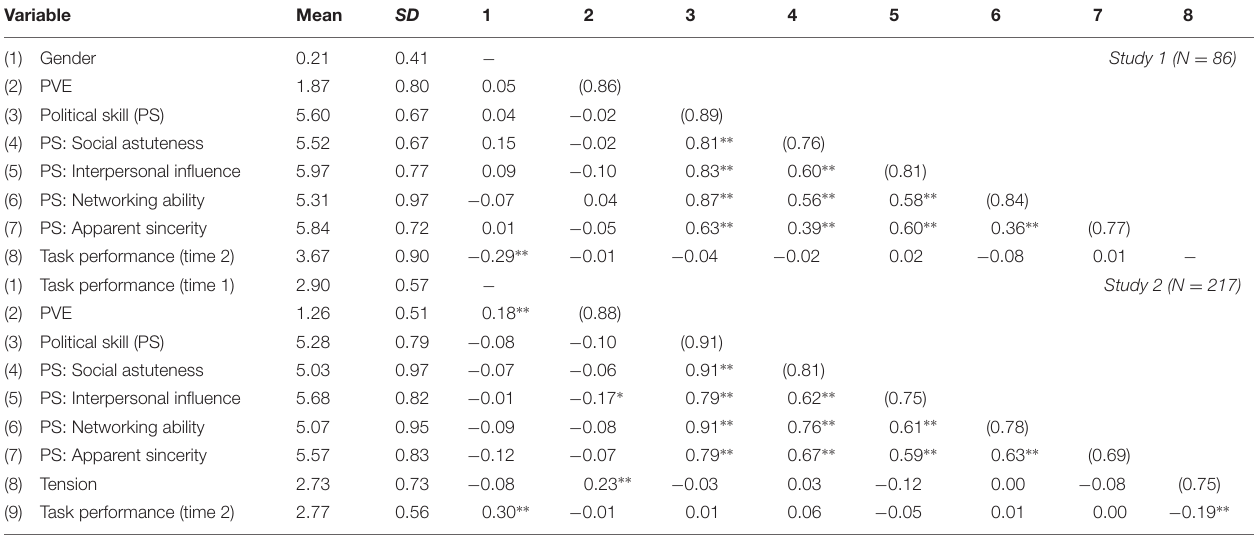
TABLE 1 | Means, standard deviations, and correlations among variables in Studies 1 and 2. Variable